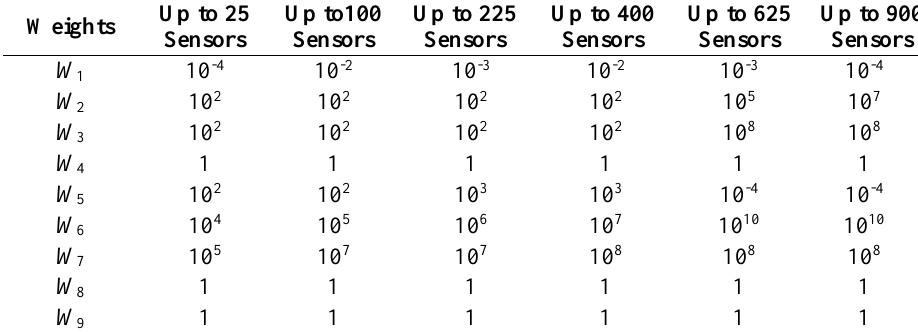
Table 2. Weighing coefficients of fitness function.